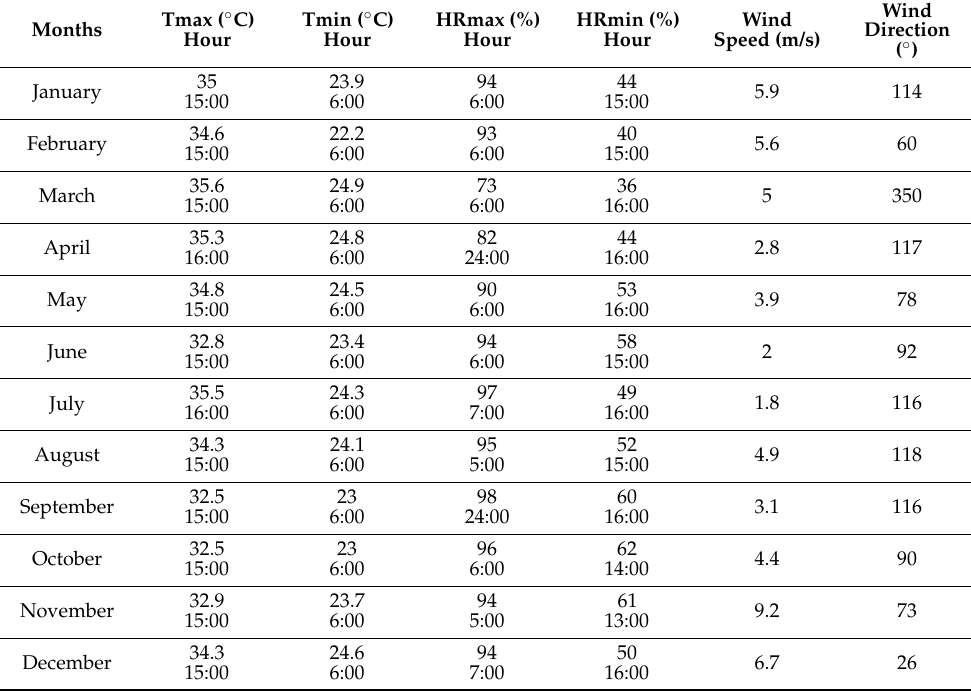
Table 3. Monthly meteorological critical values.